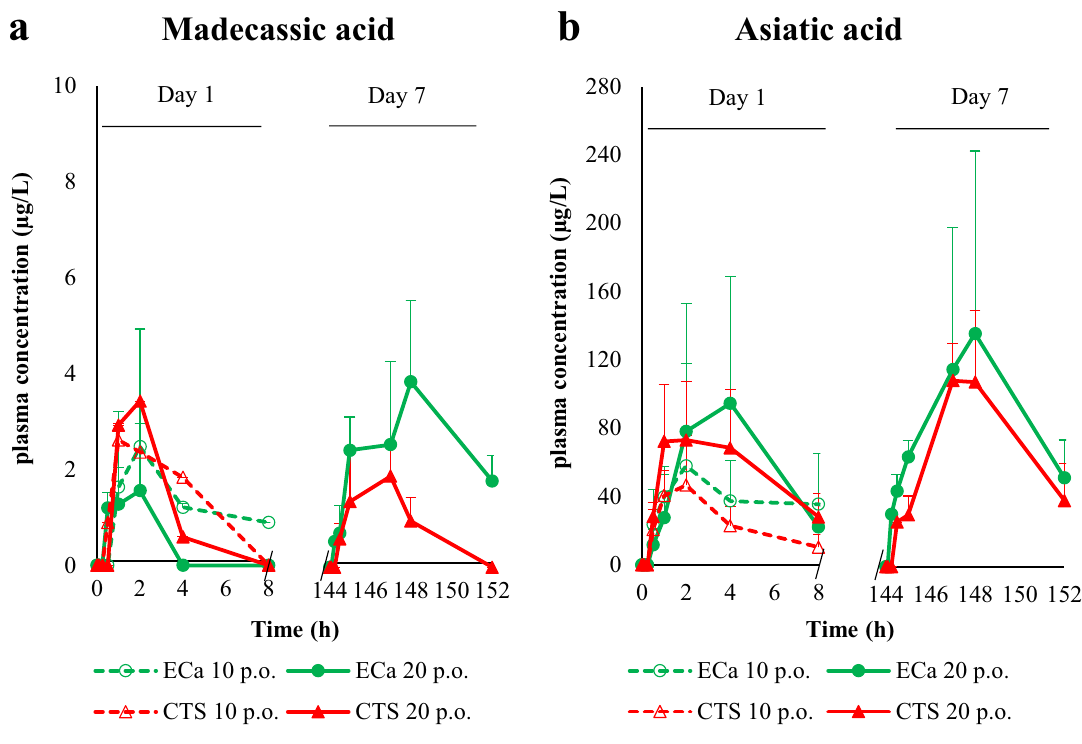
Figure 3. Plasma concentration–time profiles of madecassic acid ( a ) and asiatic acid ( b ) after oral administration of ECa 233 and Centell-S at 10 and 20 mg/kg. Data are presented as the mean ± standard deviation (n = 4).